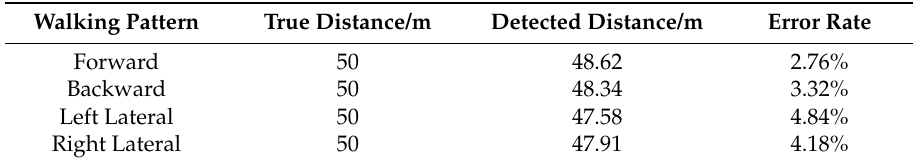
Table 2. Error of multi-pattern-based step-length.